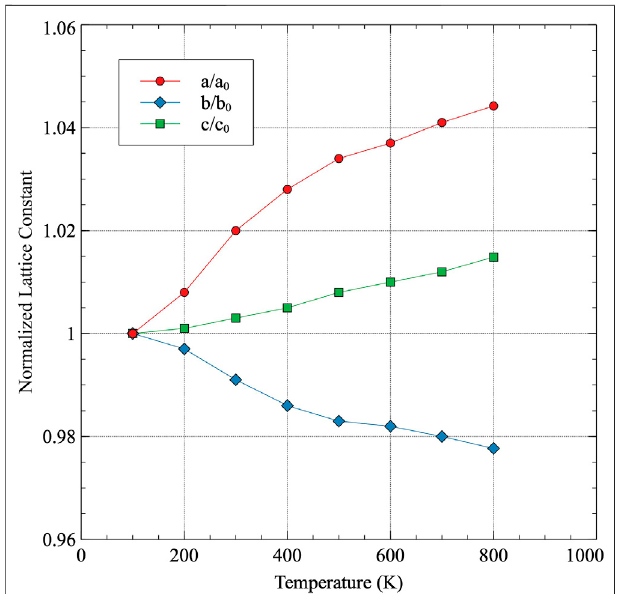
FIGURE 2 | The normalized lattice constants as a function of temperature for α -U. Each lattice constant is normalized to its value at 100 K.